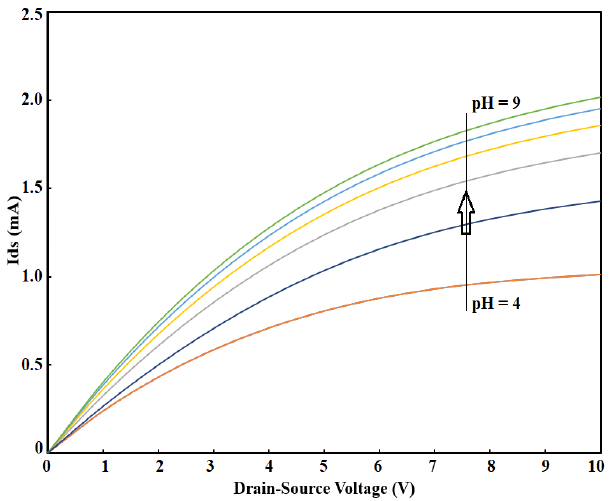
Figure 11. COMSOL simulation results of the pH variations effect on the sensor results.